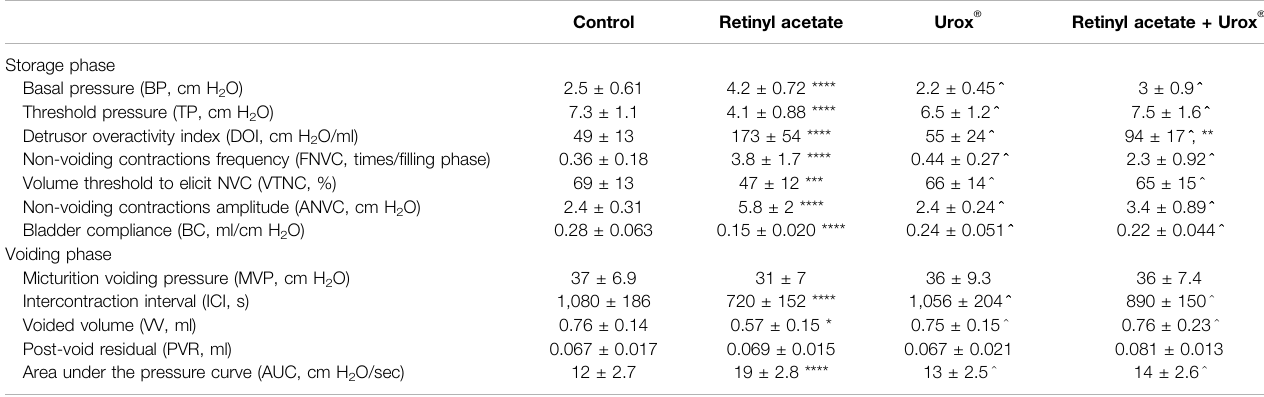
TABLE 1 | The effects of UROX ® on retinyl acetate (RA) – induced changes in cystometric parameters.